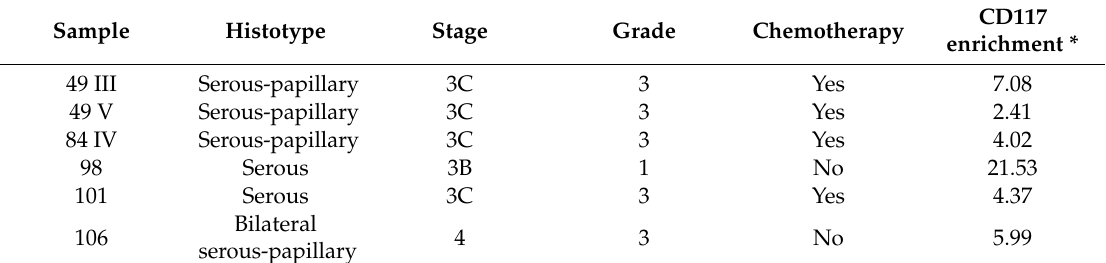
Table 2. Clinical features of EOC patients involved in the